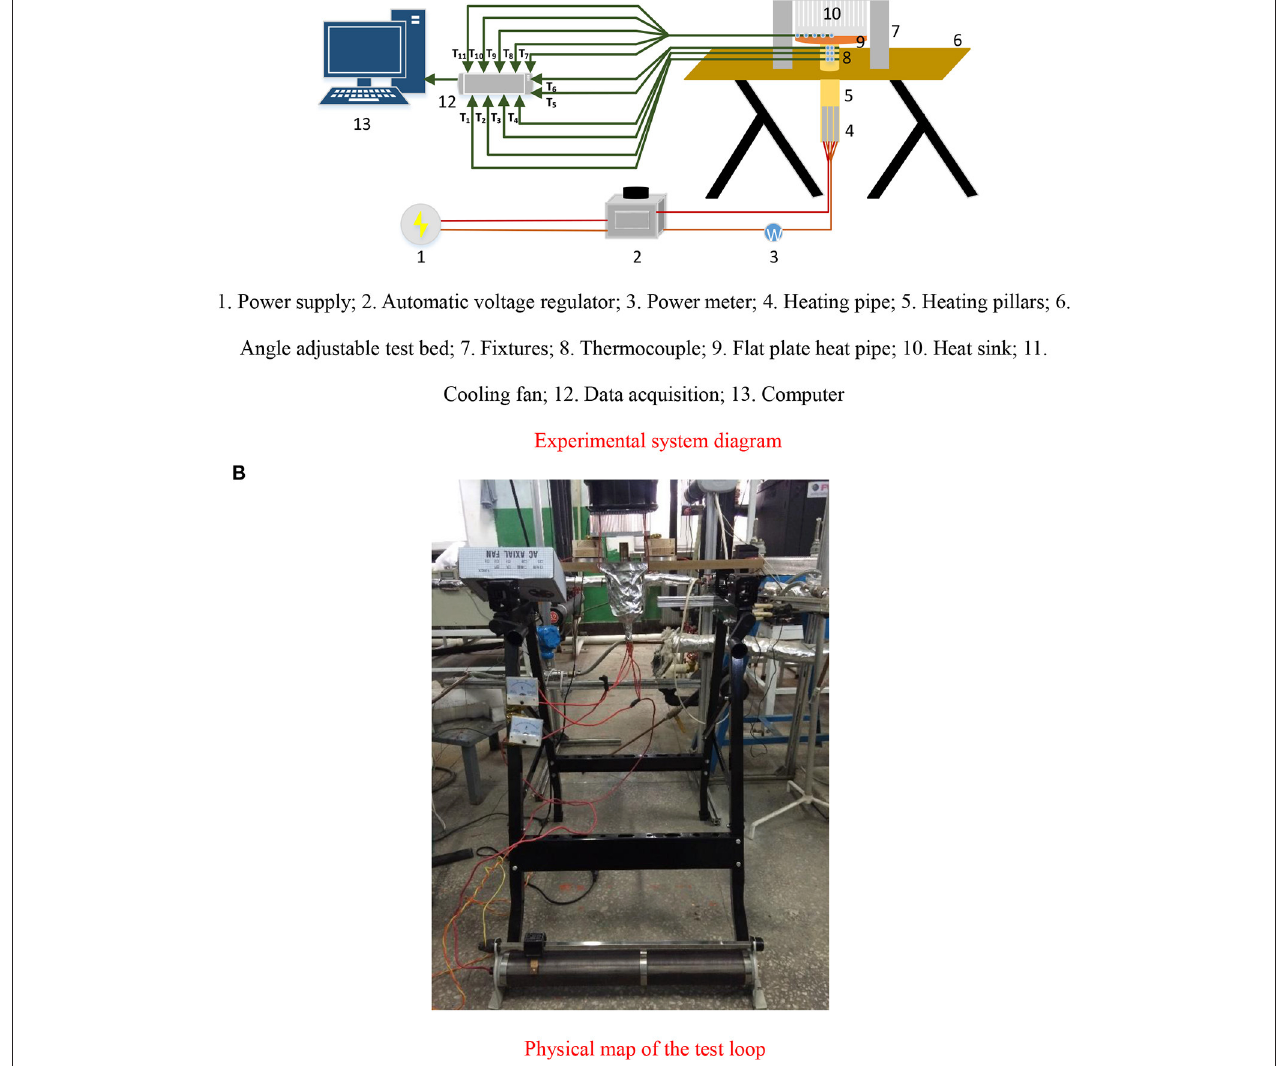
FIGURE 2 | Schematic of the experimental system. 1. Power supply; 2. Automatic voltage regulator; 3. Power meter; 4. Heating pipe; 5. Heating pillars; 6. Angle adjustable test bed; 7. Fixtures; 8. Thermocouple; 9. Flat plate heat pipe; 10. Heat sink; 11. Cooling fan; 12. Data acquisition; 13. Computer. (A) Experimental system diagram. (B) Physical map of the test